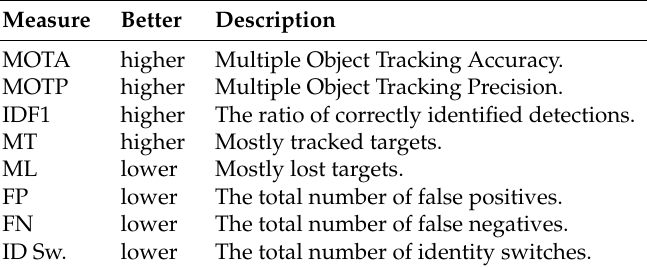
Table 3. Main evaluation